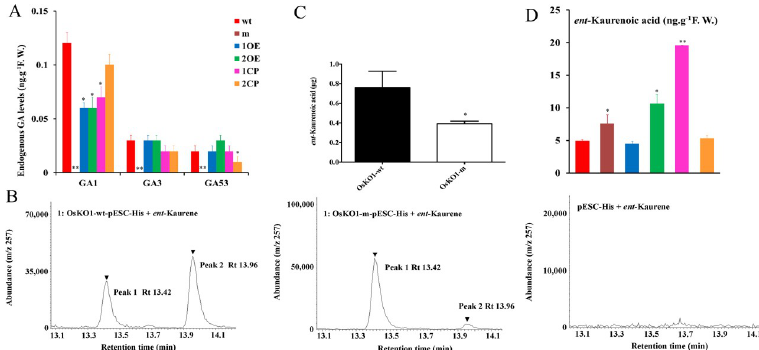
Fig 4. GA contents and OsKO1 enzyme activity analyses. (A) Endogenous GA 1 , GA 3 and GA 53 contents in the embryos of different rice lines. (B) Yeast expression and GC-MS analysis of enzyme activity of normal OsKO1 (left panel) and mutated OsKO1 (middle panel), with empty vector pESC-His transgenic yeast as negative control (right panel). GC-MS chromatograms at single ion 257 showed products ent -kaurenol (peak 1) and ent -kaurenoic acid (peak 2) catalyzed by OsKO1 from ent -kaurene. The right panel. (C) Quantitative analysis on the production of ent - kaurenoic acid between normal OsKO1 and mutated OsKO1 in the transgenic yeast system. Data are means ± SE (n = 3). (D) Endogenous content of ent -kaurenoic acid in one-month-old seedlings of different rice lines. Wild-type (wt), mutant (m) and transgenic lines in mutant background. 1OE, OsKO1 gene overexpression lines; 2OE, OsKO2 overexpression lines; 1CP, OsKO1 gene native promoter transgenic lines; 2CP, OsKO2 gene native promoter transgenic lines. Significant difference was determined by Student’s t-test ( � p < 0.05, �� p < 0.01).